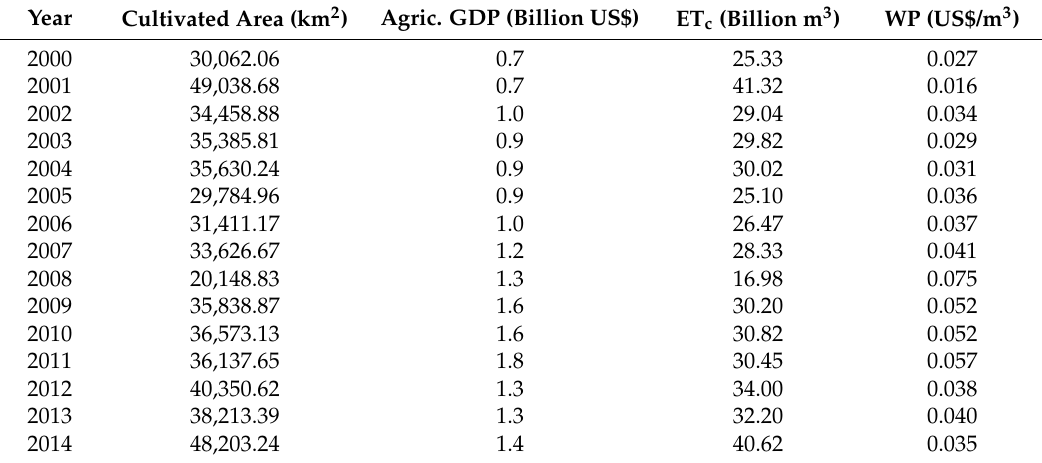
Table 3. Water productivity calculated from agricultural gross domestic product ( Ag GDP ) in Malawi. Year Cultivated Area (km 2 ) Agric. GDP (Billion